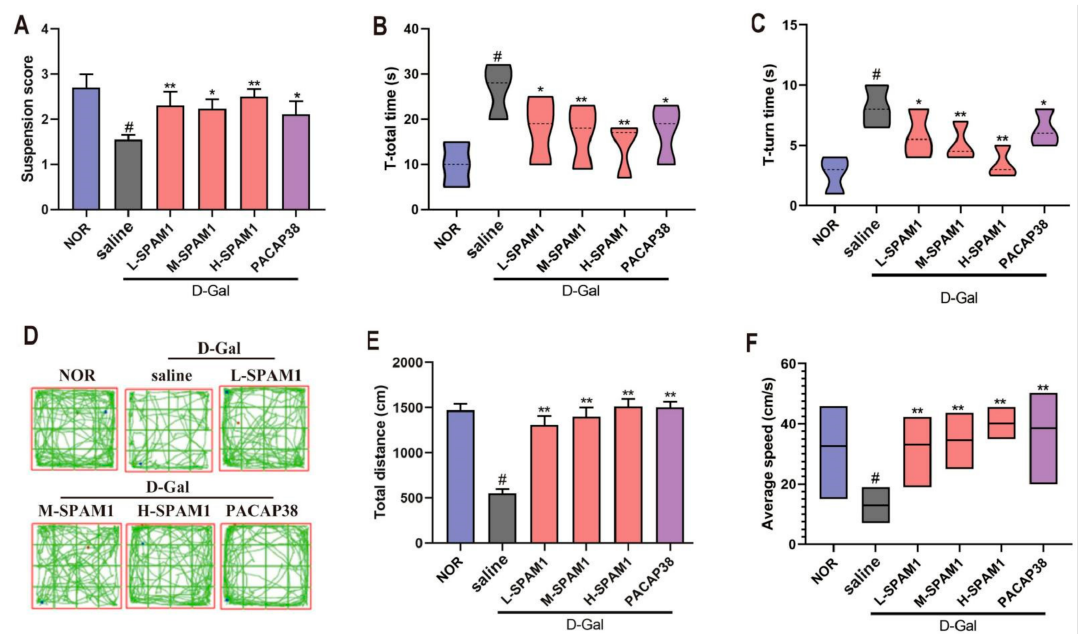
Figure 5. Effect of SPAM1 and PACAP38 on D-Gal-induced motor function impairment. The mouse D-Gal aging model were subjected to the treatment with L-SMAP1 (10 µ mol/kg/day), M-SMAP1 (40 µ mol/kg/day, H-SMAP1 (100 µ mol/kg/day) and PACAP38 (100 nmol/kg/day), respectively. ( A ) Paw suspension score showed that L-SPAM1, M-SPAM1, H-SPAM1, and PACAP38 all signifi- cantly inhibited the decrease in suspension score induced by D-gal. The average time to complete both T-turn and descending (T-total) ( B ) and average time just to complete T-turn ( C ) also showed the protective effect of SPAM1 and PACAP38 against D-Gal-induced motor impairment. ( D ) Representa- tive track maps generated from MouBeAt Software illustrated the locomotor pattern of mice during 5 min spent in the OF; locomotor activity was assessed by comparing the total distance traveled ( E ) and average speed ( F ) of mice. It was shown that SPAM1 (L, M and H) and PACAP38 significantly protected mice from the impairment of D-gal on motor functions. H-SPAM1 exhibited the most efficient protective activity, indicating SPAM1 work in concentration-dependent manner. #, p < 0.05, D-Gal group vs. control group (NOR); *, p < 0.05, vs. D-Gal group; **, p < 0.01, vs. D-Gal group. Data are presented as the mean ± SEM, n =